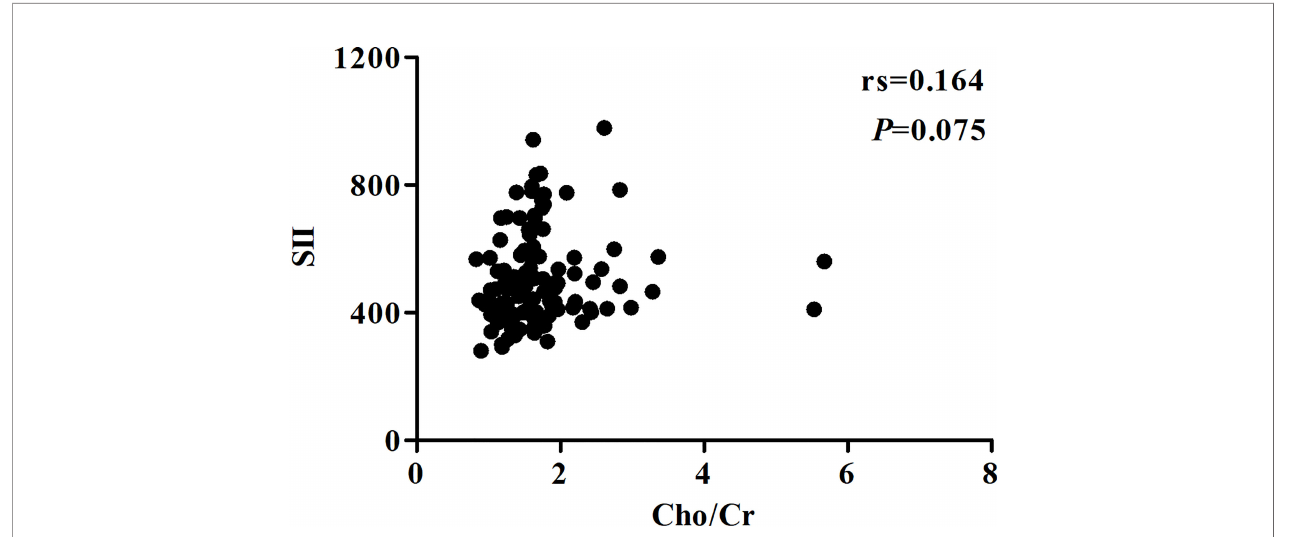
FIGURE 5 | Correlations between Cho/Cr and SII. Cho, choline; Cr, creatine; SII, systemic immune-in fl ammation